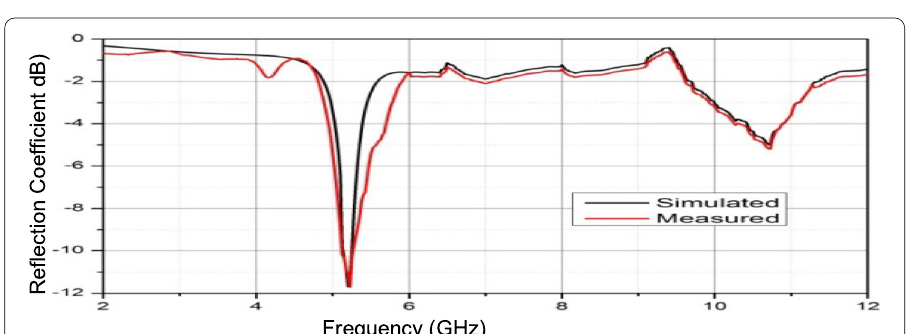
Fig. 3 Measured and simulated reflection coefficients of reference patch antenna